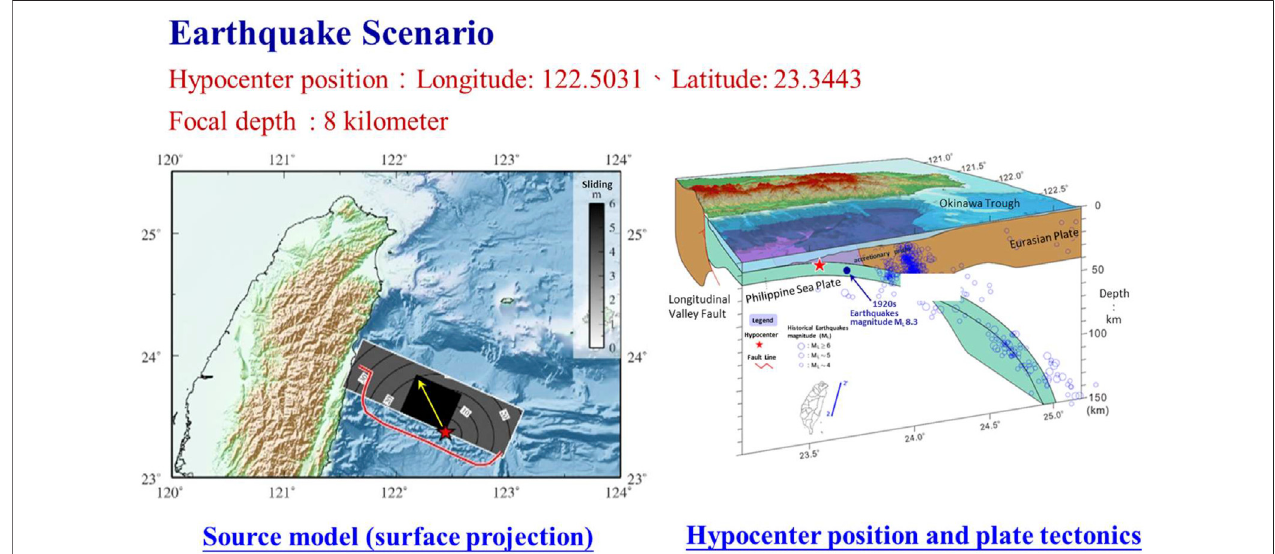
FIGURE 18 | Parameters of an earthquake